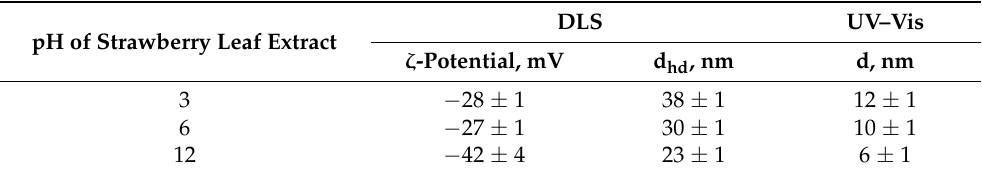
Table 3. Characteristics of sb-AuNPs obtained by UV–vis and DLS. (Synthesis: 5.0 mL of 1 mM HAuCl 4 + 0.75 mL of strawberry leaf extract with different pH).